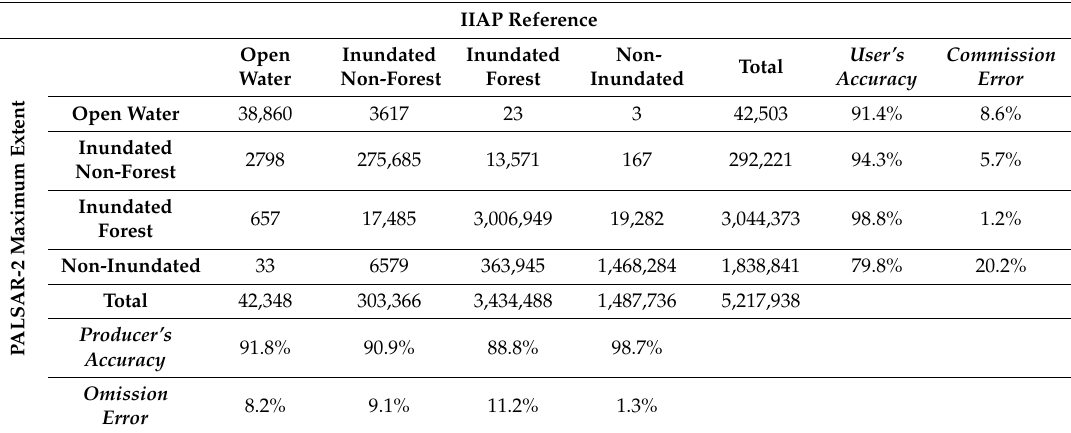
Table 2. Accuracy assessment of Step 1 maximum flooded extent classification compared with IIAP reference map of Pacaya Samiria National